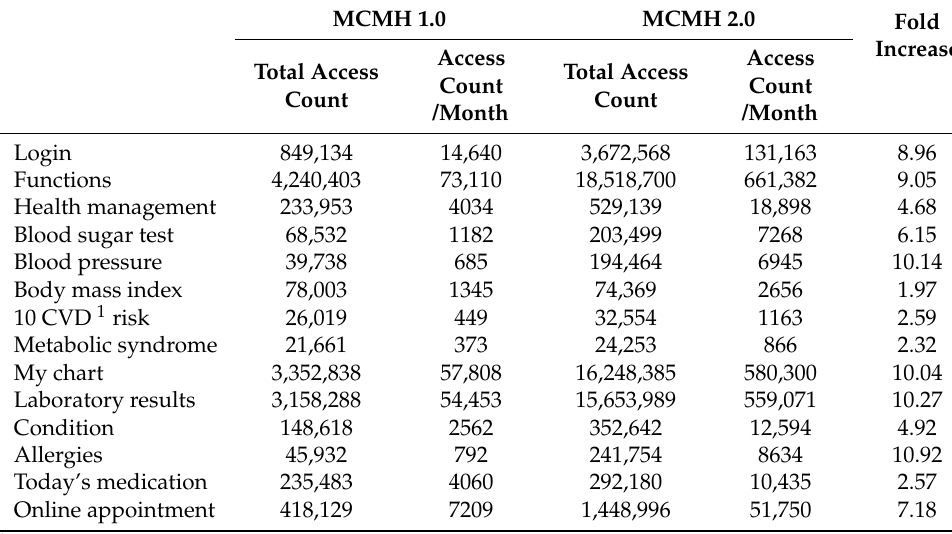
Table 3. Total access count and access count per month of the functions in My Chart in My Hand